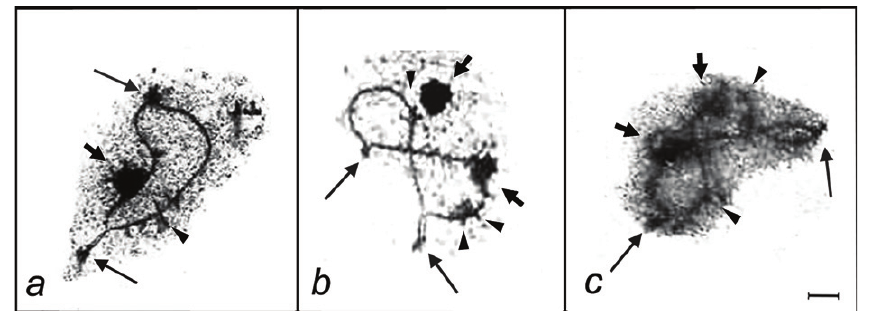
Fig. 3. The average relative length of SCs of oocytes (columns without fi ll) and spermatocytes (grey columns) of E. talpinus at pachytene. Numbers on the abscissa correspond to the length of autosomes; the 27 pair is the sex chromosomes (XX).